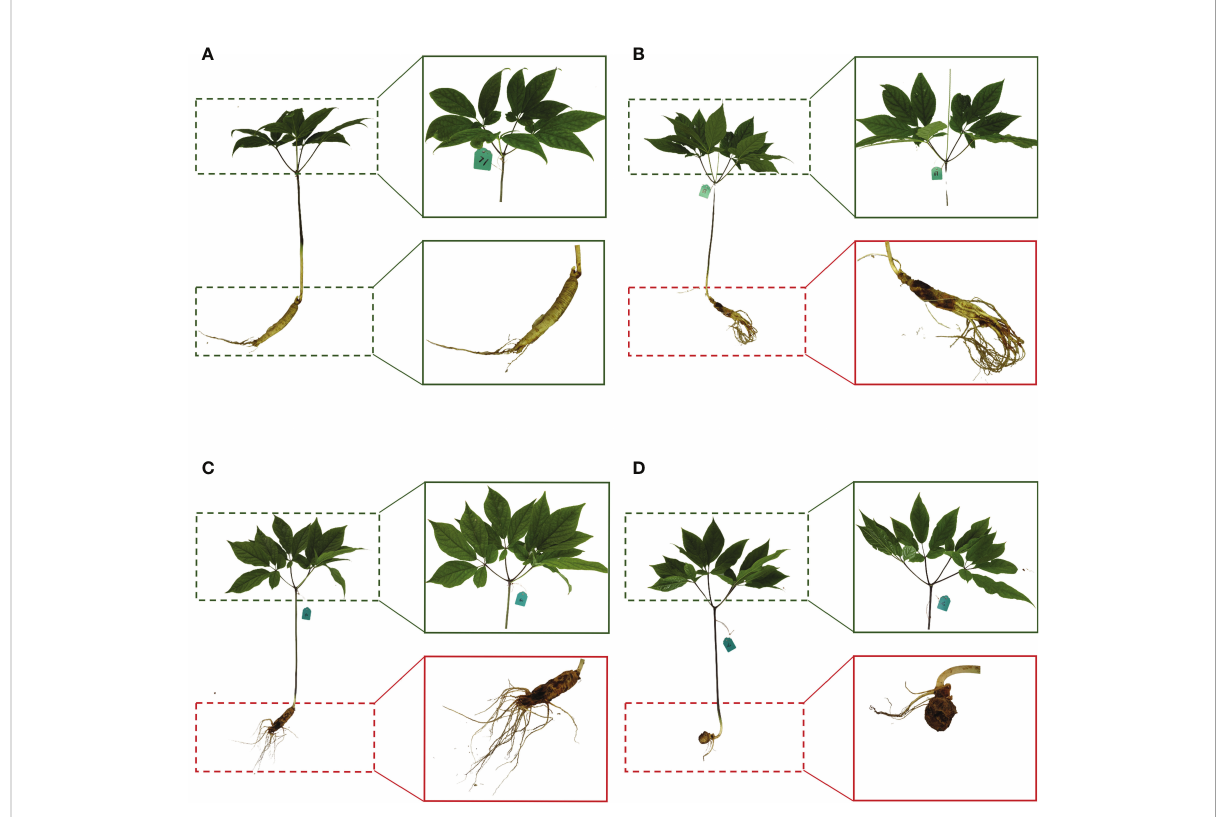
FIGURE 2 Whole plant, leaves, and root of representative healthy ginseng (A) and asymptomatic diseased ginsengs (B – D) . The dashed green box represents the healthy part, the dashed red box represents the diseased